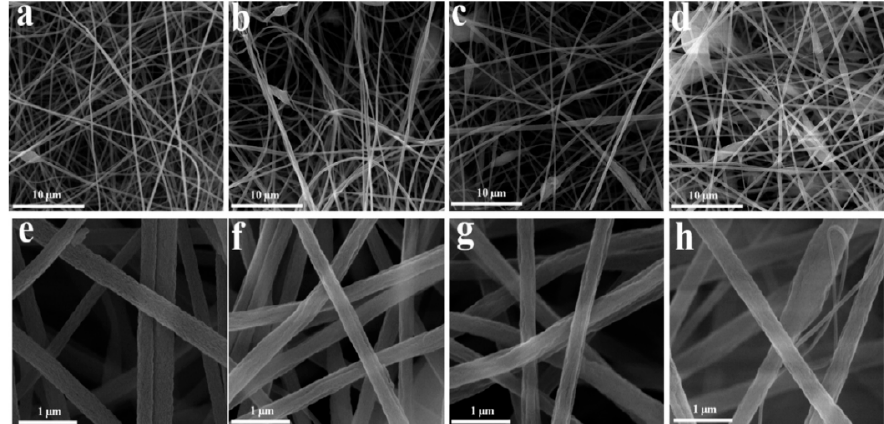
Figure 9. ( a , e ) SEM images of PAN nanofibers; ( b , f ) PAN@COF-SCU1 (0.1); ( c , g ) PAN@COF-SCU1 (0.2); ( d , h ) PAN@COF-SCU1 (0.3). Reprinted with permission from Ref. [94]. Copyright (2020) Else- vier.